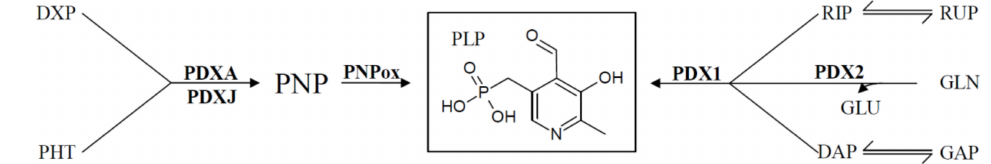
Figure 2. The two known de novo pathways leading to the biosynthesis of PLP. The two de novo pathways, DXP-dependent and -independent, use pyridoxine 5 (cid:48) -phosphate synthase (PDXJ) and 4-hydroxythreonine-4-phosphate dehydrogenase (A) and PDX1 and 2 enzyme, respectively, to synthesize PLP. DXP, Deoxyxylose 5 (cid:48) -phosphate; DAP, Dihydroxyacetone phosphate; DXP, 1-Deoxyxylulose-5-phosphate; GAP, Glyceraldehyde-3-phosphate; GLN, L-Glutamine; GLU, L-Glutamate; PHT, 4-Phosphohydroxy-L-threonine; PLP, Pyridoxal-5-phosphate; PNP, Pyridoxine-5-phosphate; RIP, Ribose-5-phosphate; RUP,